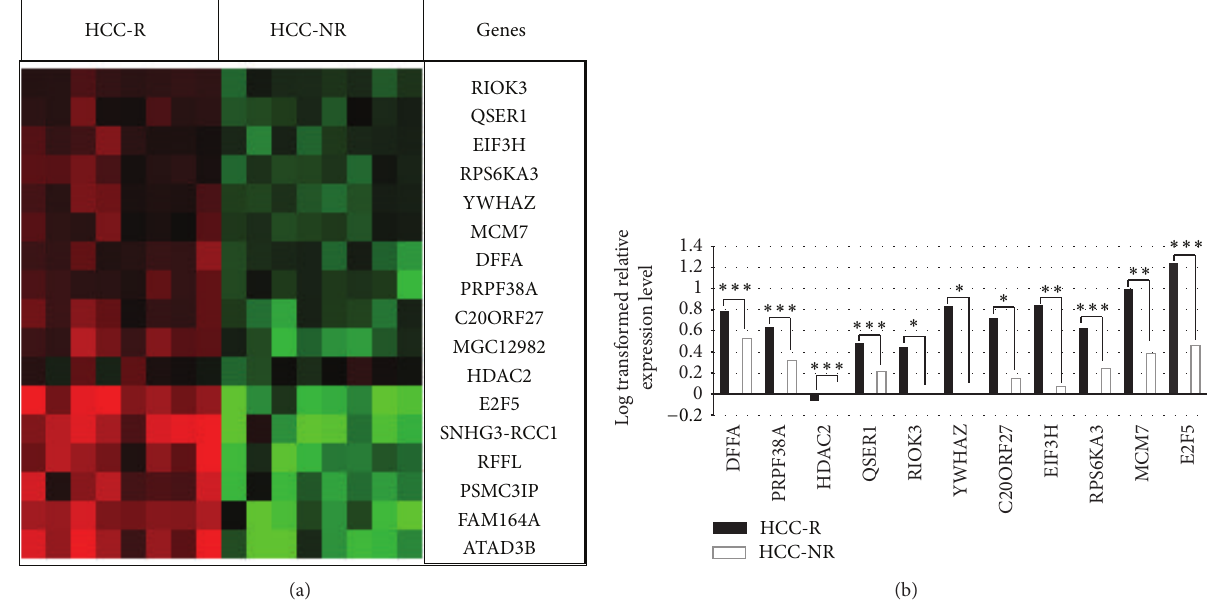
Figure 6: Validation of microarray data by qPCR. The 𝑃 values were calculated with Student’s 𝑡 -test ( ∗∗∗ < 0.05; ∗∗ < 0.07; ∗ < 0.25).